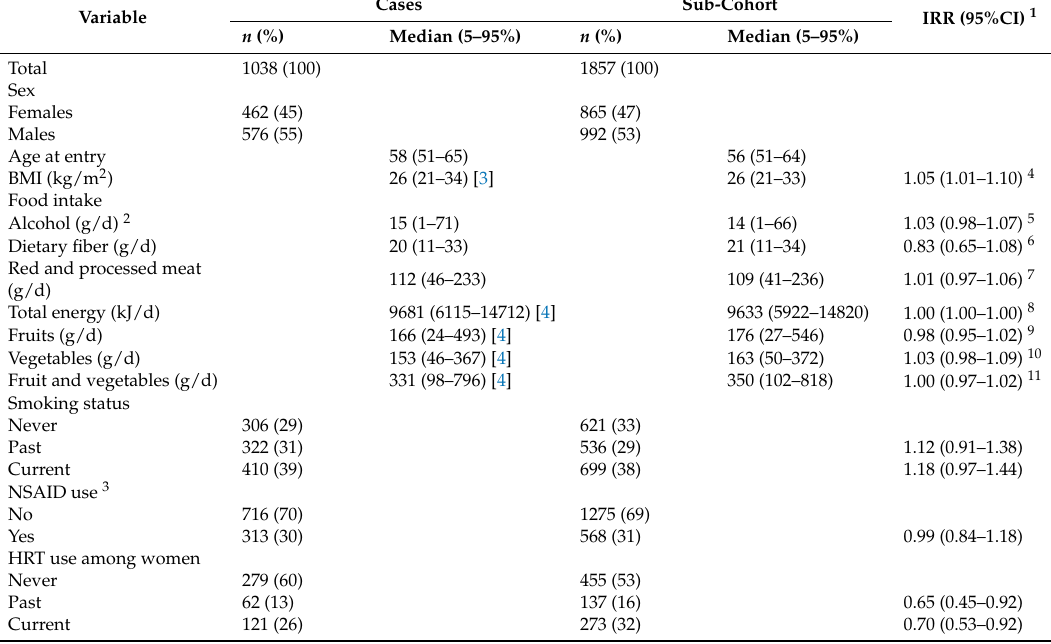
Figure 1. Flowchart of study participants. Figure 1 . Flowchart of study participants. Table 1. Participant Table 1. Participant description.